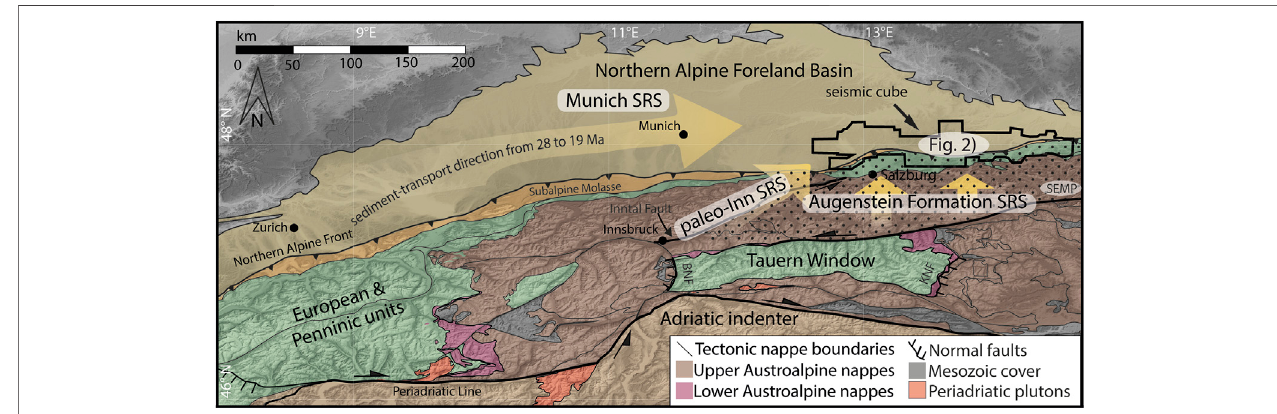
FIGURE1| Simpli fi edgeologicalmap oftheAlpsshowing theTauern Windowintheeastbounded bytwonormal faults[afterSchmid et al.(2004)].The locationof the seismic re fl ection cube in the Upper Austrian NAFB is enlarged in Figure 2 . The three different sediment-routing systems (SRS) to the Upper Austrian NAFB are indicated by yellow arrows. SEMP = Salzach-Ennstal-Mariazell-Puchberg Fault; BNF = Brenner Normal Fault, KNF = Katschberg Normal Fault.